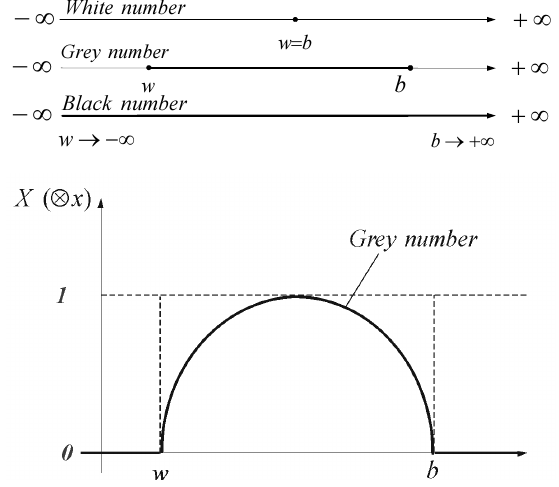
Fig. 4. White, grey and black numbers by Deng (Yamaguchi et al .